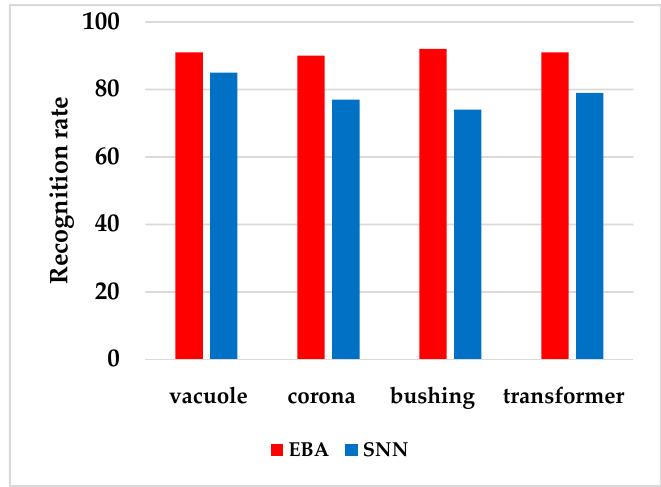
Figure 10. Recognition efficiencies of training and testing with each of the PD defects.